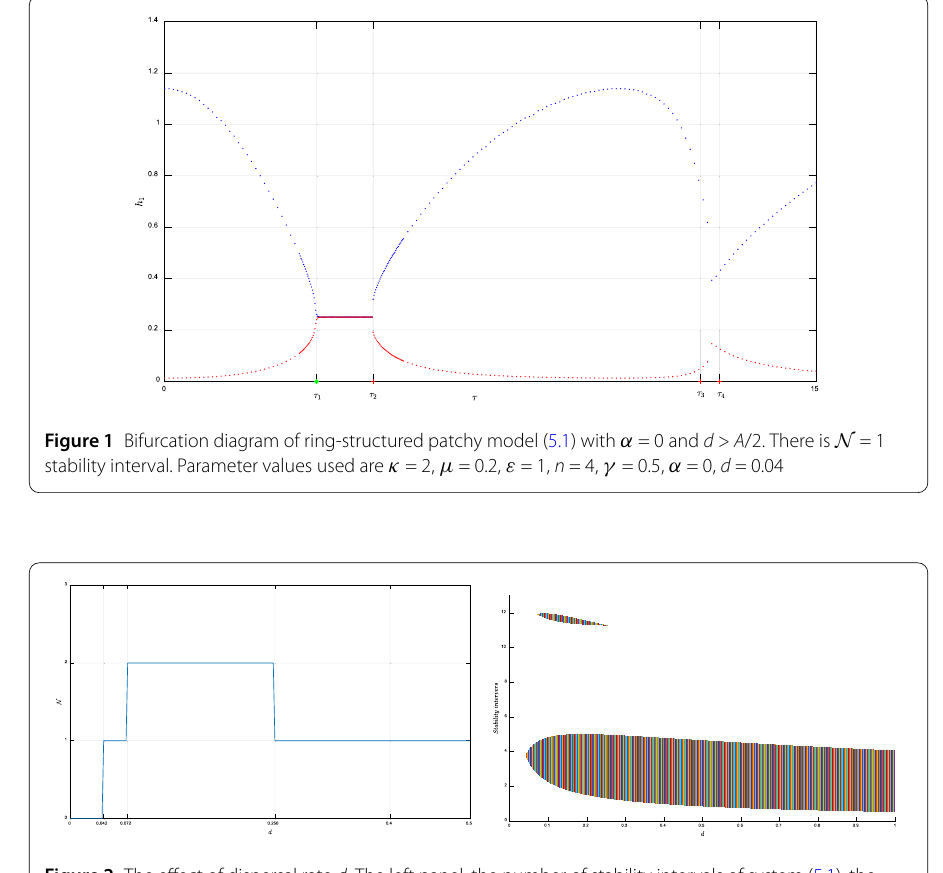
Figure 2 The effect of dispersal rate d . The left panel: the number of stability intervals of system (5.1); the right panel: the distribution of stability intervals system (5.1). The parameter values are α = 0.5, (cid:15) = 1, κ = 2, μ = 0.2, γ = 0.5, n = 4